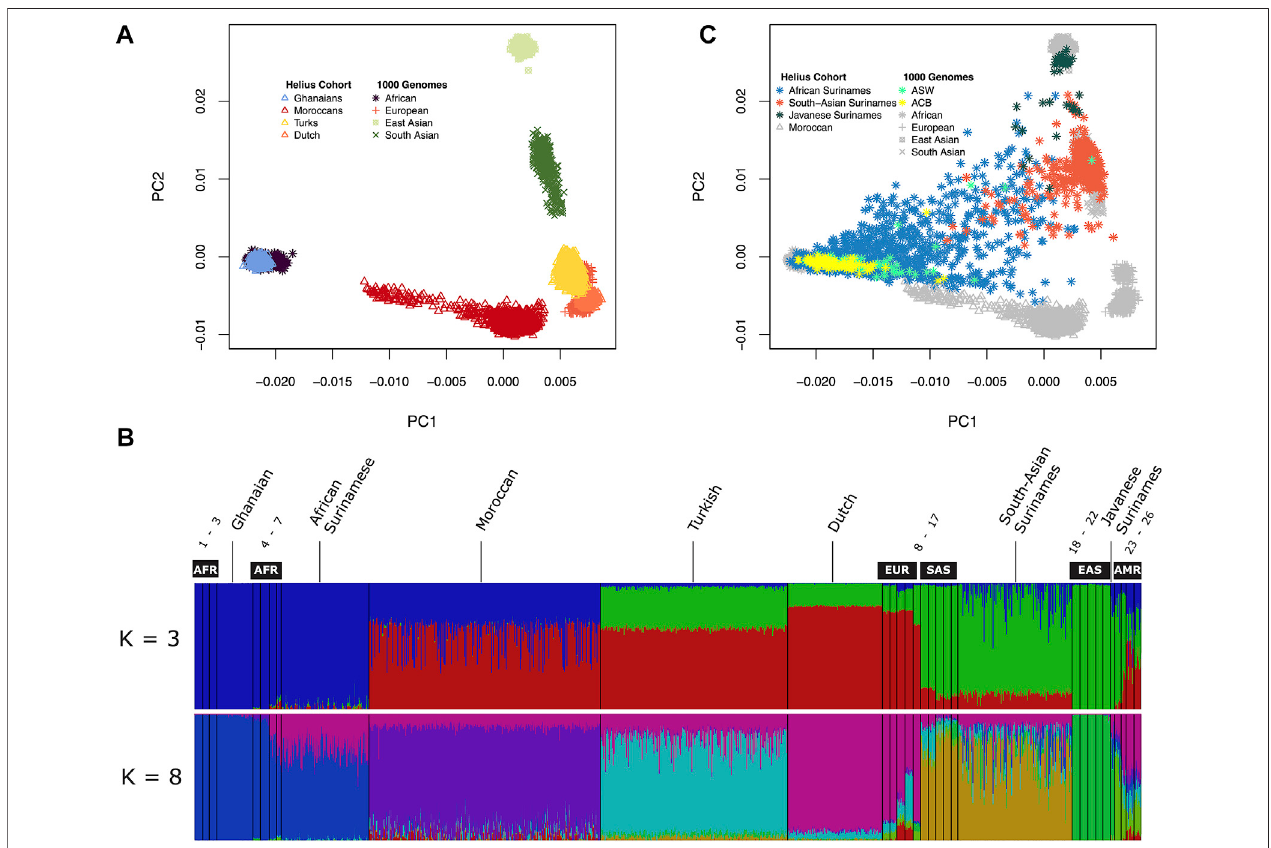
FIGURE 1 | Genetic diversity between the HELIUS Cohort populations. Ancestry was explored by merging the HELIUS cohort together with the 1000 Genome project populations. Differences were fi rst inferred by using principal components analysis (PCA). (A) First two PCAs of the non-admixed populations grouped at their continental origin. Population ancestry was estimated using ADMIXTURE. (B) Results of a genome-wide ancestry with K (cid:1) 3 or 8 ancestral populations. All HELIUS populations are displayed, and 1000G populations are marked by their continental origin (AFR (cid:1) African, EUR (cid:1) European, SAS (cid:1) South Asian, EAS (cid:1) East Asian, and AMR (cid:1) Admixed America). Numbers indicate the exact 1000G populations which can be found in Supplementary Figure S3 . PCA of the Surinamese HELIUS participants in (C) together with the African American (ASW) and African Caribbean (ACB) admixed 1000G populations